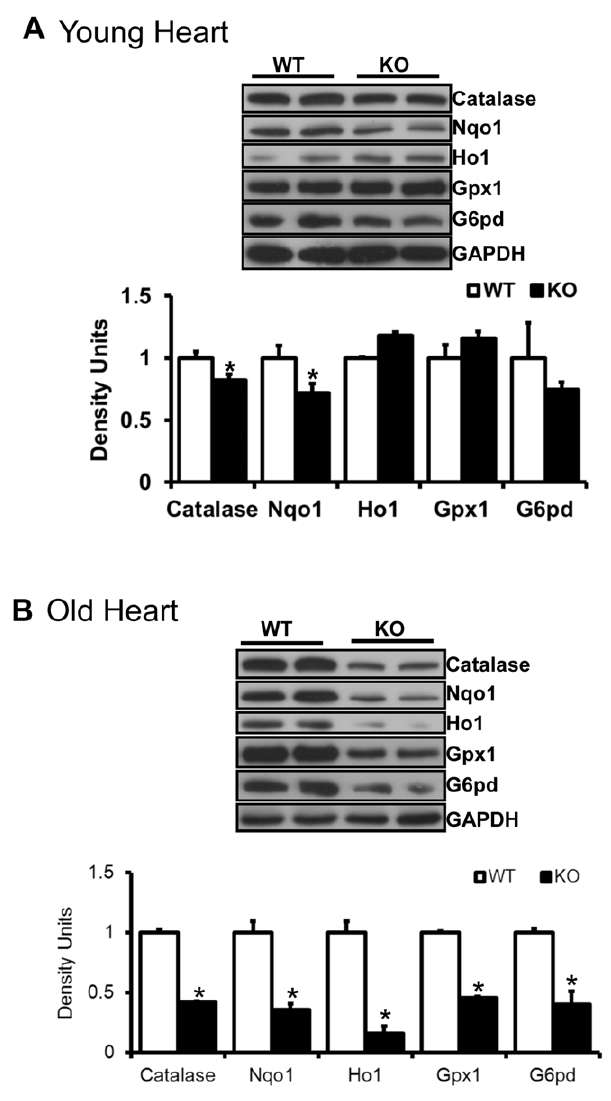
Figure 2. Myocardial antioxidants in young and old mice. Immunoblots showing antioxidant enzymes in hearts of young (2 months) and old ( . 23 months) mice. About 30 m g of cytosolic proteins from ventricle tissues were resolved on PAGE and probed for respective antibodies. Significant (p , 0.05) differences were observed between WT and Nrf2-/- mice at older age